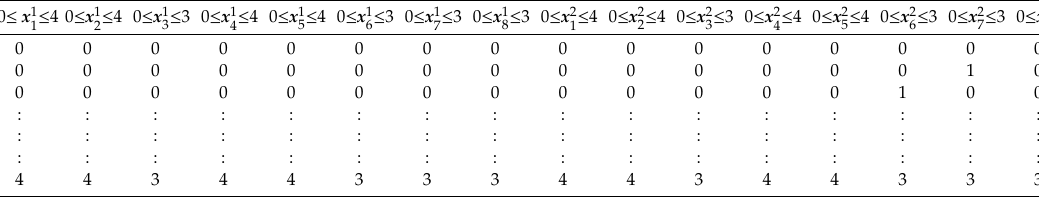
Table 19. The process of the exhaustive method.